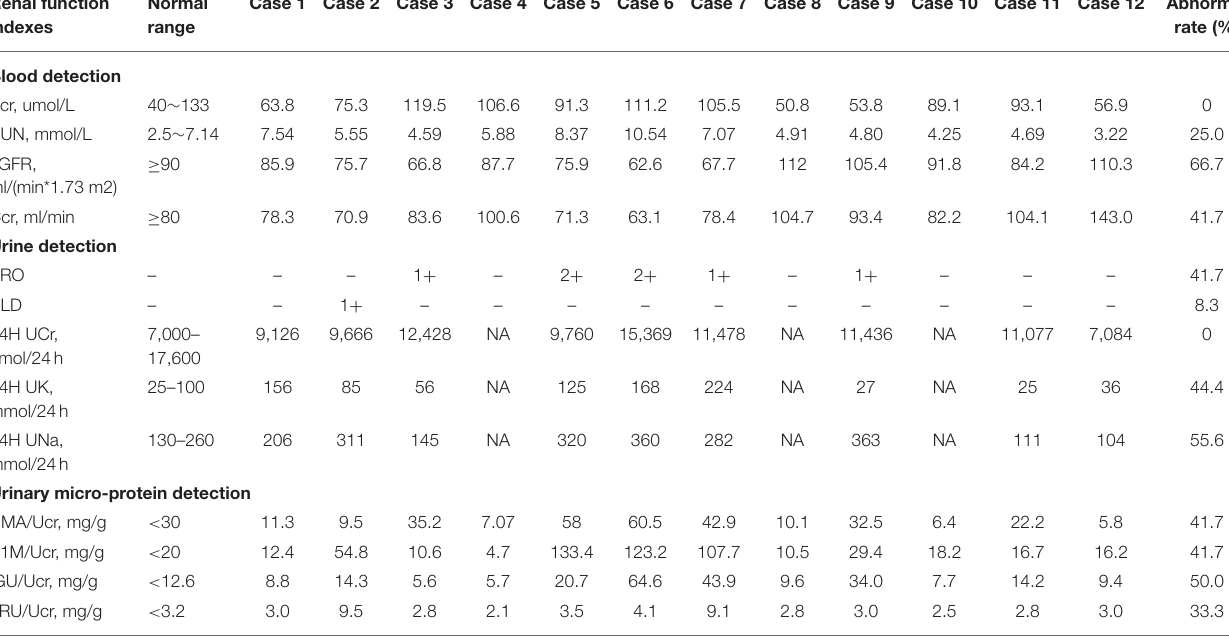
TABLE 1 | Renal function indicators of the COVID-19 patients in peak of disease. Renal function indexes